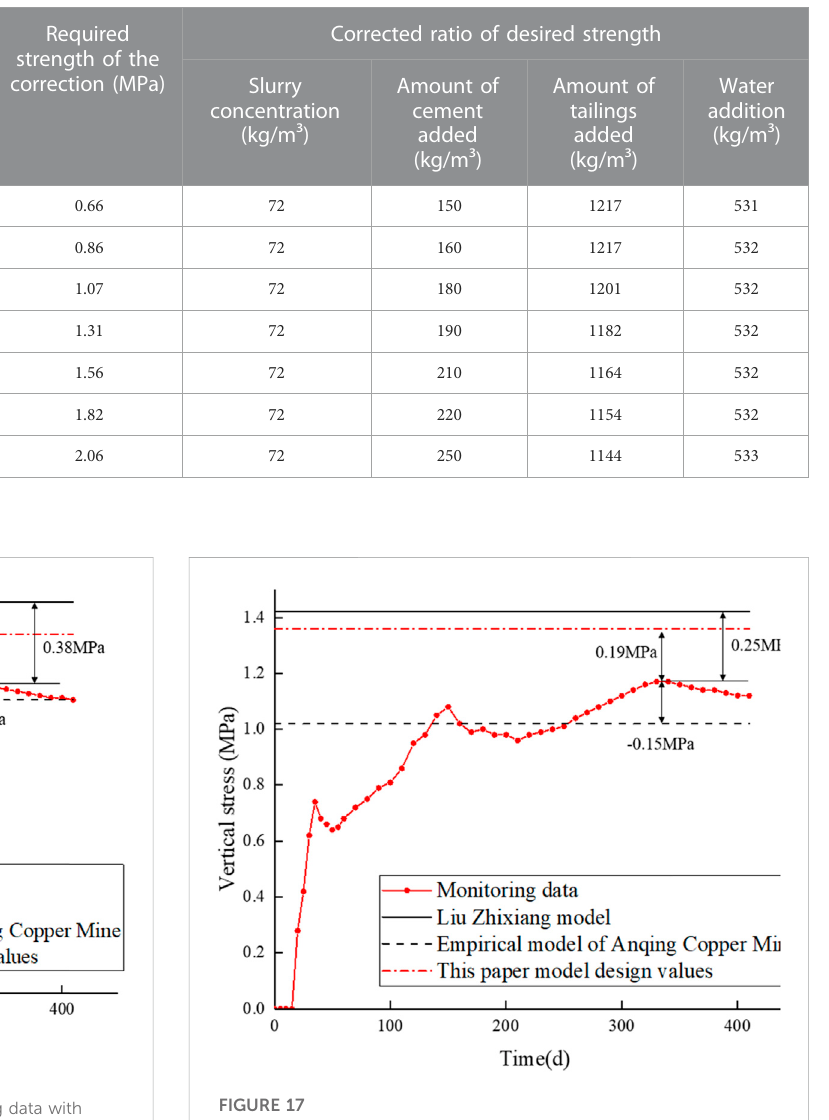
FIGURE 17 Curve showing changes in #10 pressure cell monitoring data with